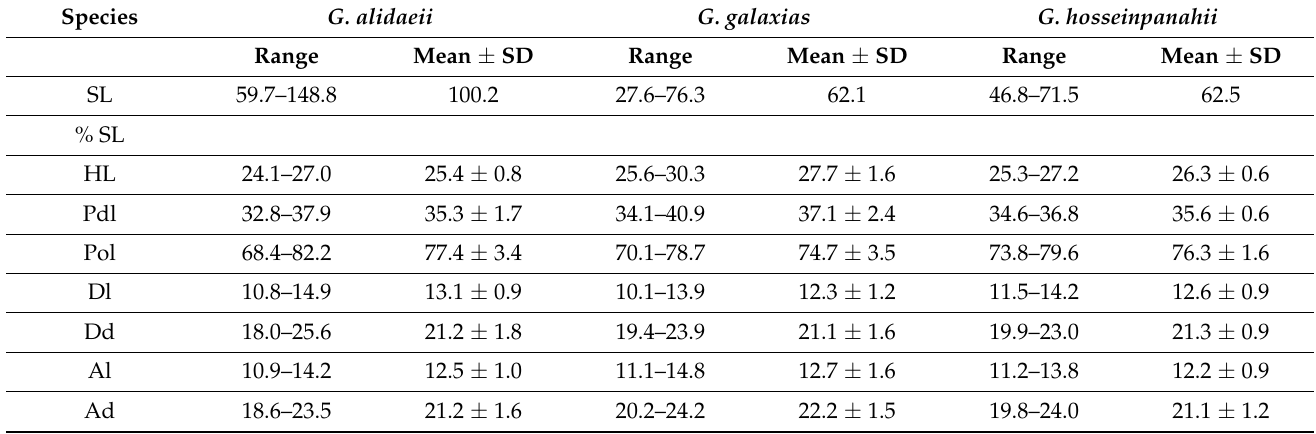
Figure 6. Glyptothorax spp. ( a ), ZM-CBSU H959, 55.2 mm SL; Ab e Aala R.; ( b ), H903, 68.4 mm SL; Bashar R.; ( c ), H949, 71.5 mm SL; Fahlian R.; ( d ), H997, 112.6 mm SL; Kashkan R.; ( e ), H970, 70 mm SL; Kohmareh Sorkhi R.; ( f ), H983, 90.2 mm SL; Seimareh R.; ( g ), H979, 72.2 mm SL; Gamasiab R.; ( h ), 1256/5, 92 mm SL; Sirvan R. Table 3. Morphometric data of Glyptothorax alidaeii (ZM-CBSU H901, Bashar River, n = 8; ZM-CBSU H983, Seimare River, n = 9; ZM-CBSU H997, Kashkan River, n = 5), G. galaxias (ZM-CBSU H975, Gamasiab River, n = 6), G. hosseinpanahii (ZM-CBSU H942, Fahlian River, n = 10), G. shapuri (ZM-CBSU H918, Kohmareh Sorkhi River, n = 16), G. silviae (ZM-CBSU H955, Ab-e Aala River, n = 9) and G. cous (ZM-CBSU H974, H982, n =